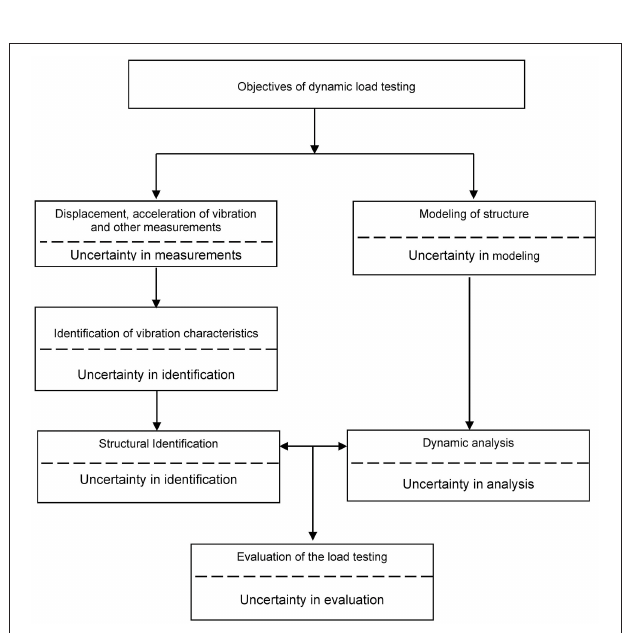
FIGURE 2 | Block diagram of dynamic test loading process during acceptance tests of a bridge structure; developed on the basis (ISO 18649, 2004).